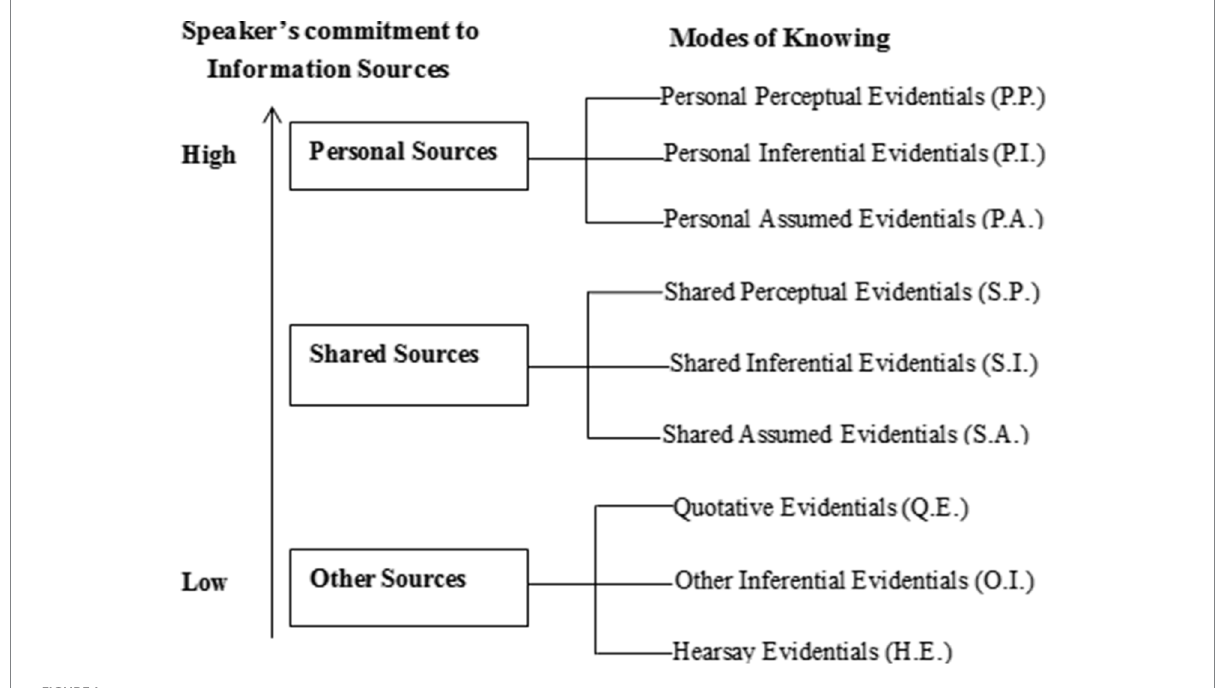
FIGURE 1 An analytical framework of English